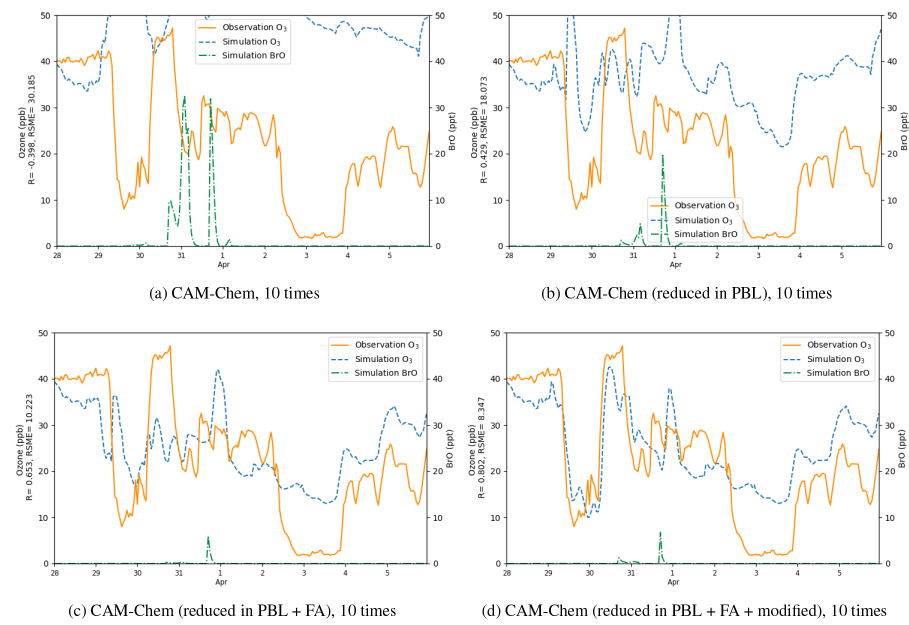
Figure 13. Surface ozone (ppb) obtained from simulations and observations together with the simulated BrO at Barrow from 28 March to 5 April 2019. The correlation coefficient R and the root-mean-square error RMSE are also presented on the vertical axis. Simulations were performed using different boundary conditions: (a) time-dependent boundary condition adopted from the outputs of CAM-Chem, (b) outputs of CAM-Chem with a reduction in ozone in the PBL, (c) outputs of CAM-Chem with a reduction in ozone in the PBL and the free atmosphere, (d) outputs of CAM-Chem with a reduction in ozone in the PBL and the free atmosphere as well as a modification of ozone over the Chukotka Peninsula. Table 2. Values of the Pearson correlation coefficient ( R ) and the root-mean-square error (RMSE; unit: ppb) for the simulated surface ozone at Barrow under different conditions (the heterogeneous reaction rate and boundary conditions). The rate constant of the heterogeneous reaction suggested by Mellberg (2014) was multiplied by 0.0, 1.0, 5.0, and 10.0 and then tested in different simulations. In addition, different boundary conditions (default BC in CMAQ, original CAM-Chem outputs, reduced CAM-Chem outputs but without the modification over the Chukotka Peninsula, reduced and modified CAM-Chem outputs) were also